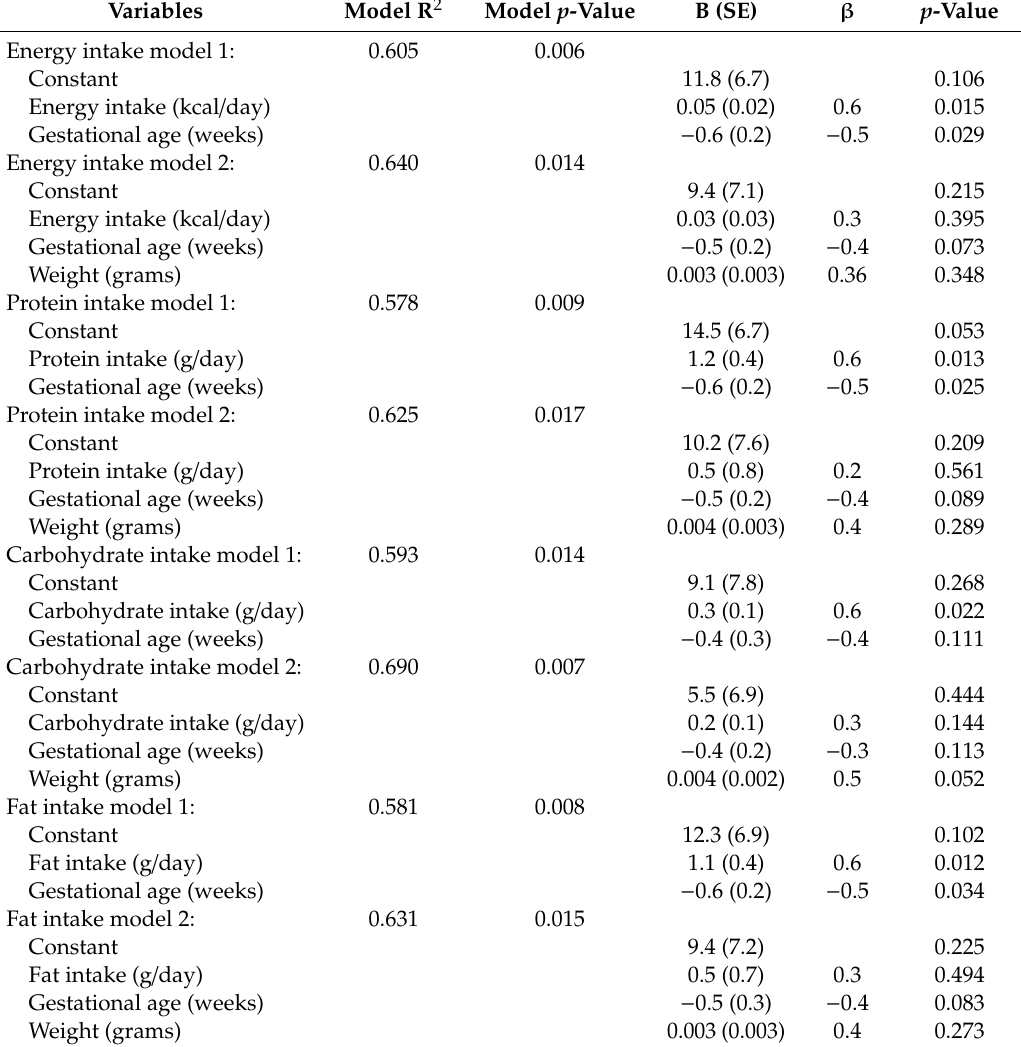
Table 5. Regression analyses of intake as a predictor of IGF-1 levels at 30 weeks postmenstrual